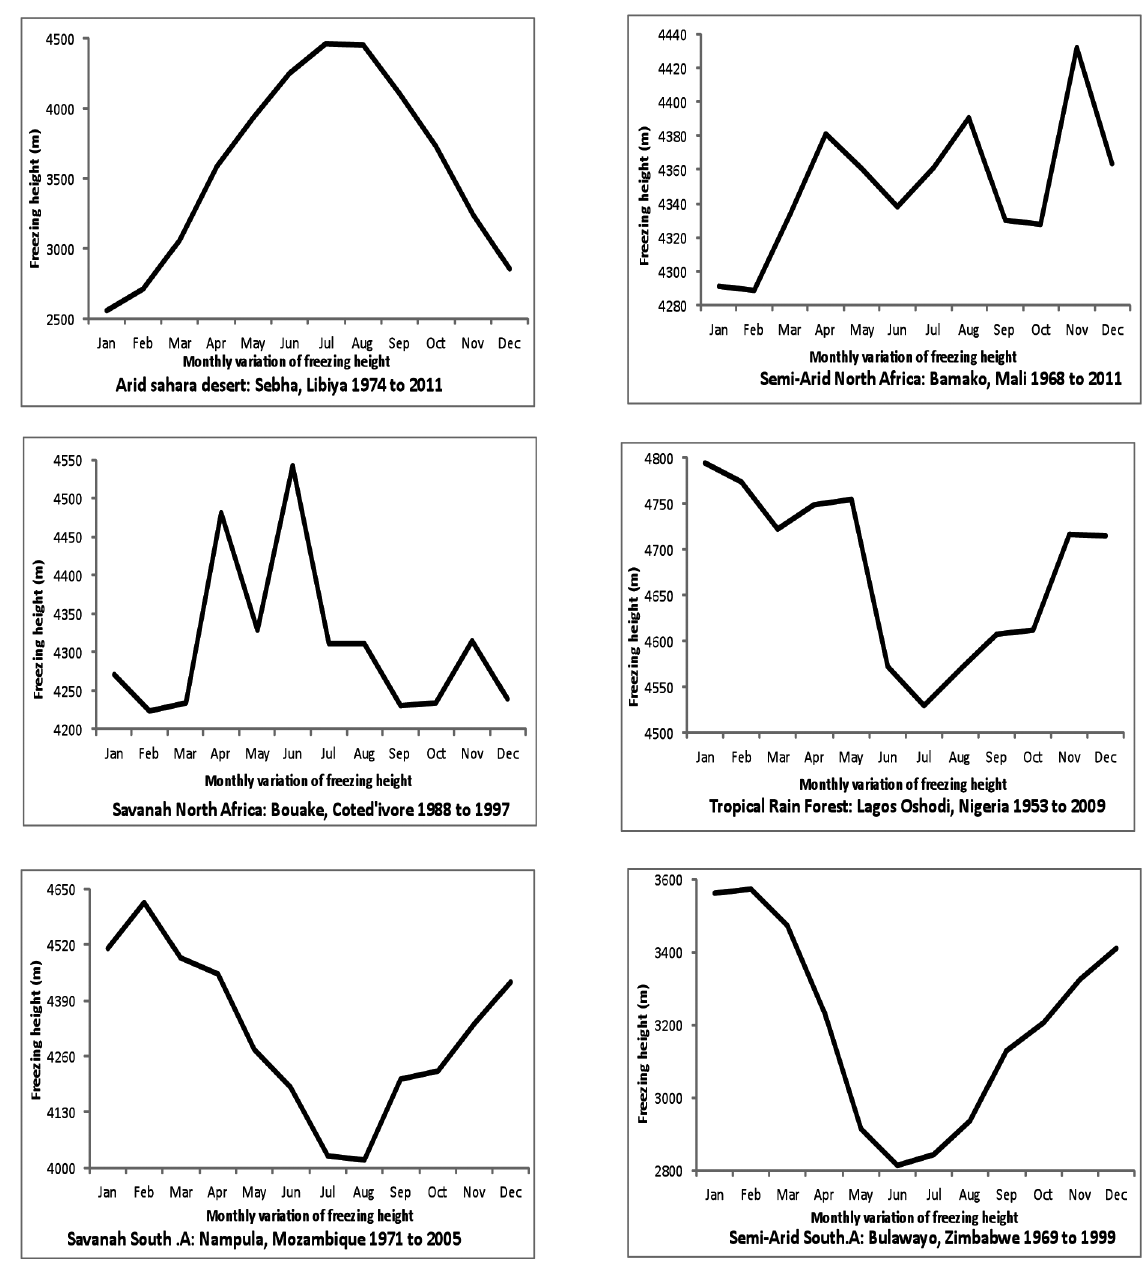
Figure 7. Monthly variation of 0°C isothermal height derived from daily radiosonde